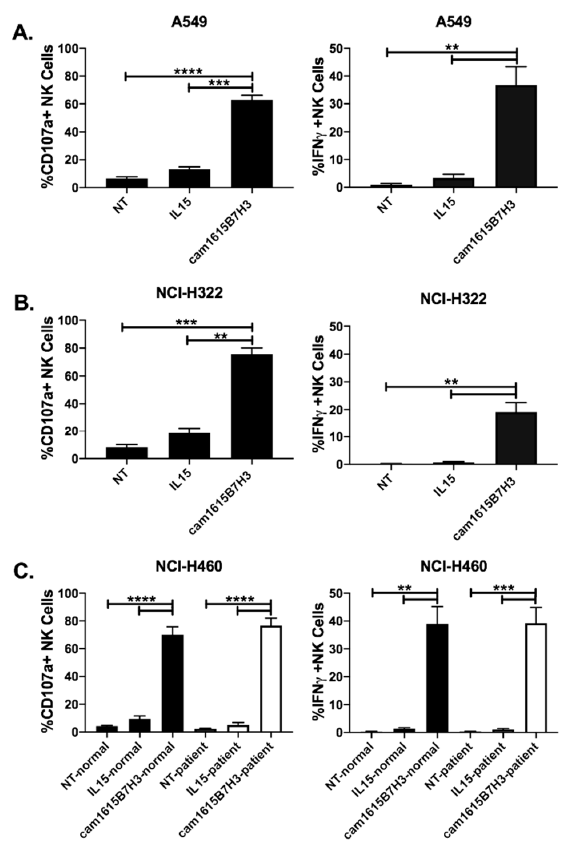
Figure 5. cam1615B7H3 TriKE enhances NK cell function against lung tumor targets. Pooled analysis of proportion of NK cells from healthy donors expressing CD107a + ( left ) or IFN γ ( right ) against ( A ) A549 (N = 6) and ( B ) NCI-H322 (N = 5) tumor targets. ( C ) Pooled proportion of NK cells from healthy donors (black bars) or lung cancer patients (white bars) expressing CD107a + or IFN γ against NCI-H460 (N = 7). ** p < 0.01, *** p < 0.001, and **** p < 0.0001.